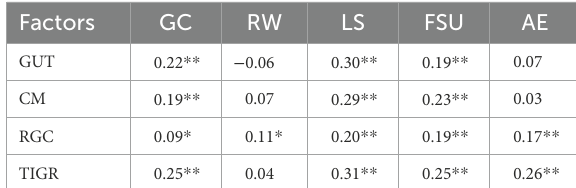
TABLE 3 The correlations among C-DNAS and